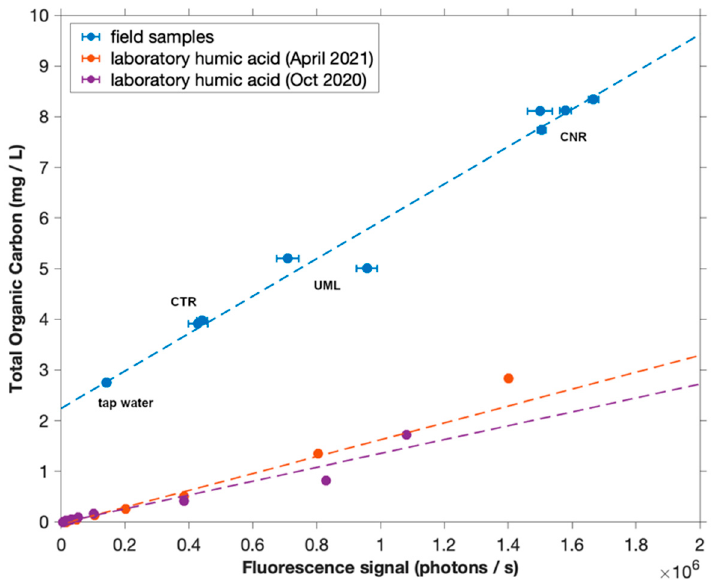
Figure 2. Calibration of photon counter using in situ field measurements compared to TOC of grab samples as measured by analyzer. Calibrations with laboratory Sigma Aldrich humic acid are shown for comparison.